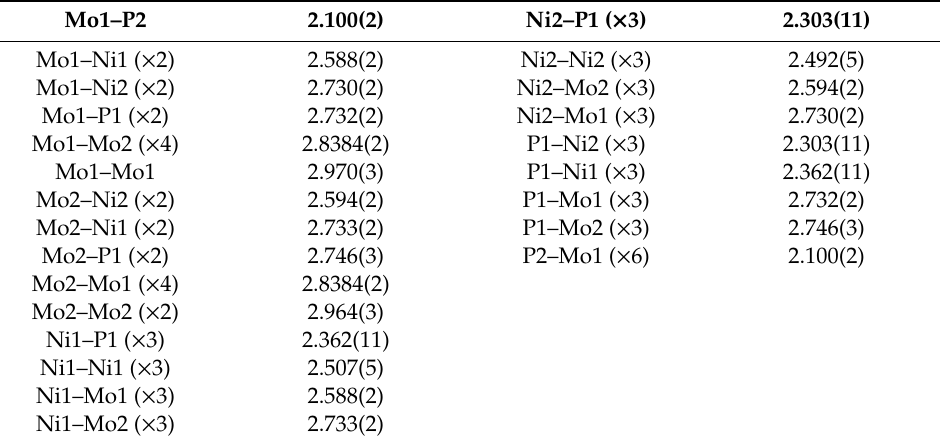
Table 4. Selected bond distances (Å) for